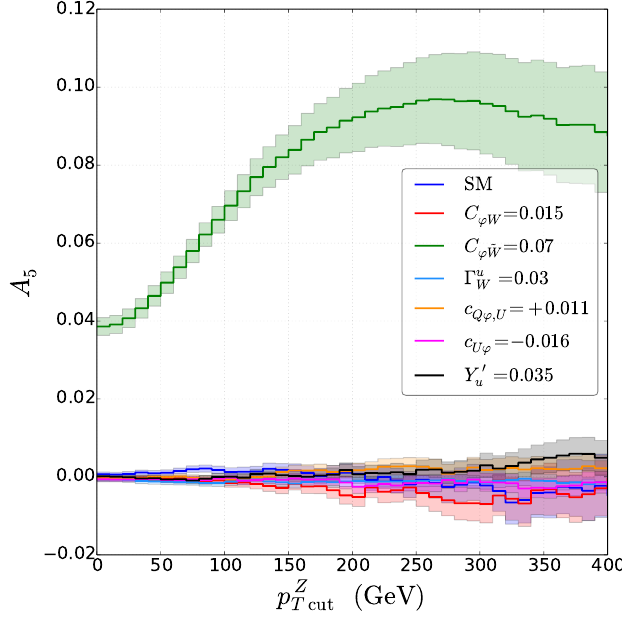
p , at S = 13 TeV. T cut